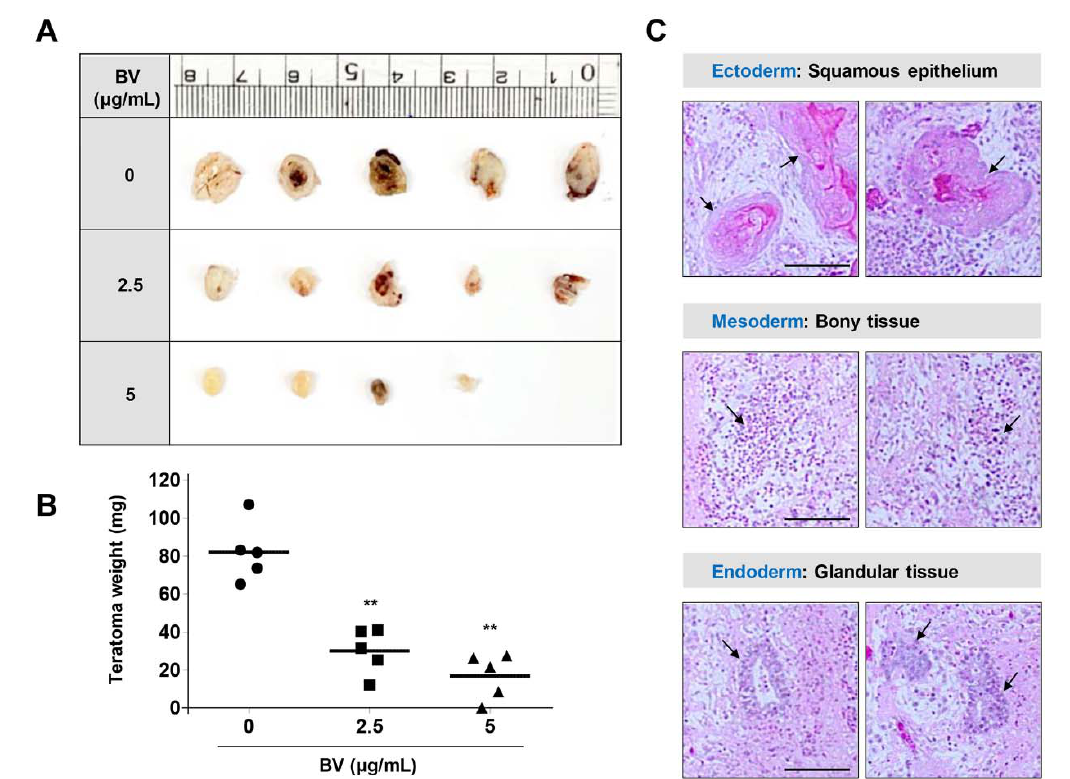
Figure 5. Suppression of in ovo teratoma formation of iPSCs by BV treatment. ( A , B ) On ED day 10, Matrigel plugs containing BV-treated or -untreated iPSCs were loaded on CAMs and then further grown for 8 days in an egg incubator. On ED day 18, teratomas were excised from chorioallantoic membrane (CAM), photographed, and measured for weight. Data are expressed as means ± SD ( n = 5). ** p < 0.01 vs. BV-untreated control ( C ) Teratomas generated from BV-untreated iPSCs were analyzed after hematoxylin-eosin (H&E) staining. Arrows indicate cells derived from three germ layers, including ectoderm, mesoderm, and endoderm,